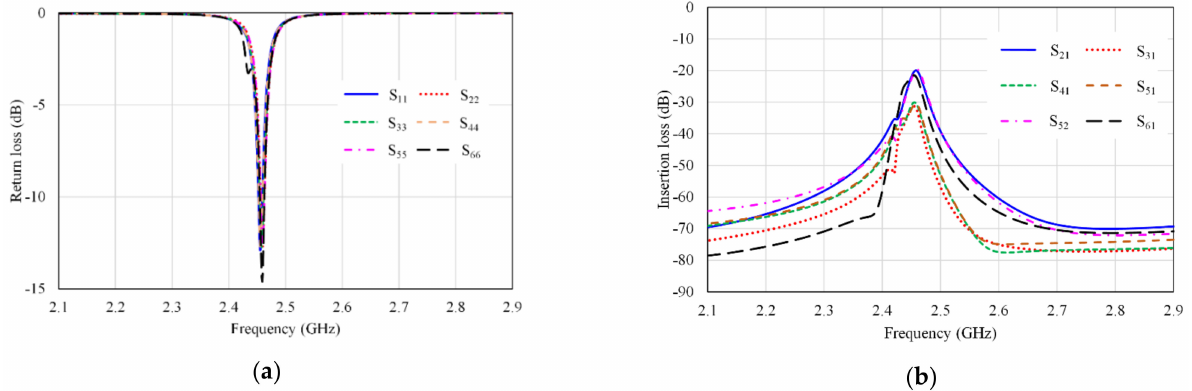
Figure 7. S-parameters for the six-port MIMO antenna array ( a ) return loss (S ii ), and ( b ) insertion loss (S ij